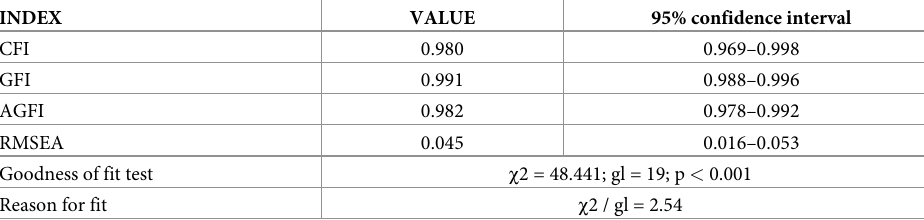
Table 5. Indices of goodness of fit of the exploratory factor analysis to the